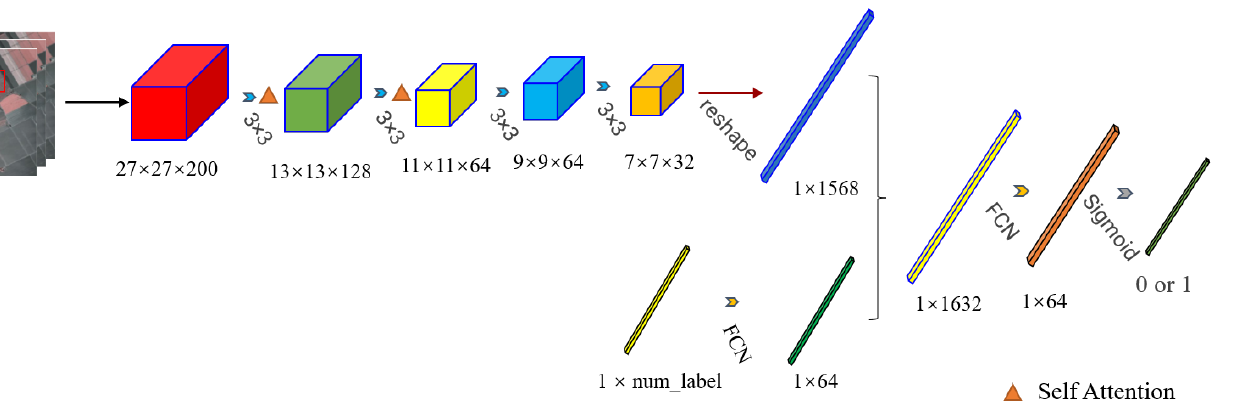
Figure 3. The structure of the discriminator D